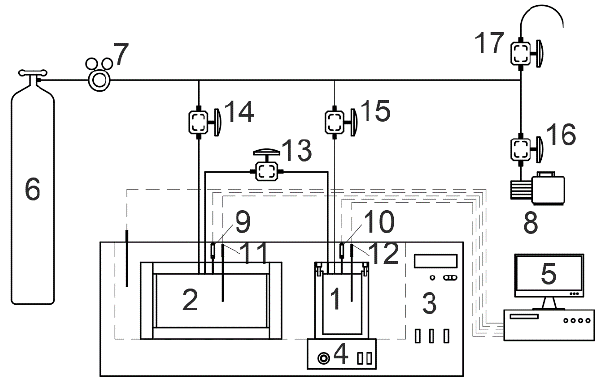
Figure 1. Schematic diagram of experimental setup. (1) high ‐ pressure reactor; (2) buffer tank; (3) thermostatic bath; (4) magnetic stirrer; (5) data acquisition; (6) gas cylinder; (7) Pressure relief valve; (8) vacuum pump; (9,10) pressure transducer; (11,12) thermometer; (13–17) needle valves.